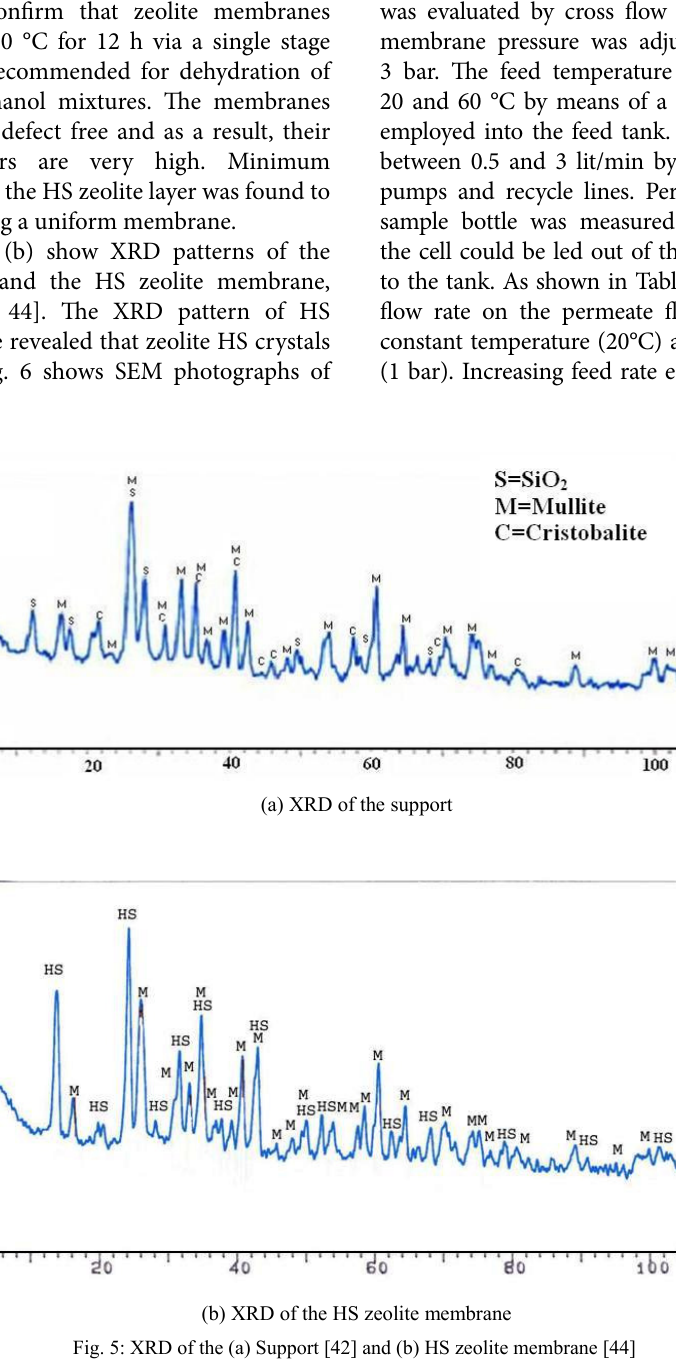
Fig. 5 XRD of the (a) Support [42] and (b) HS zeolite membrane [44] Fig. 5: XRD of the (a) Support [42] and (b) HS zeolite membrane